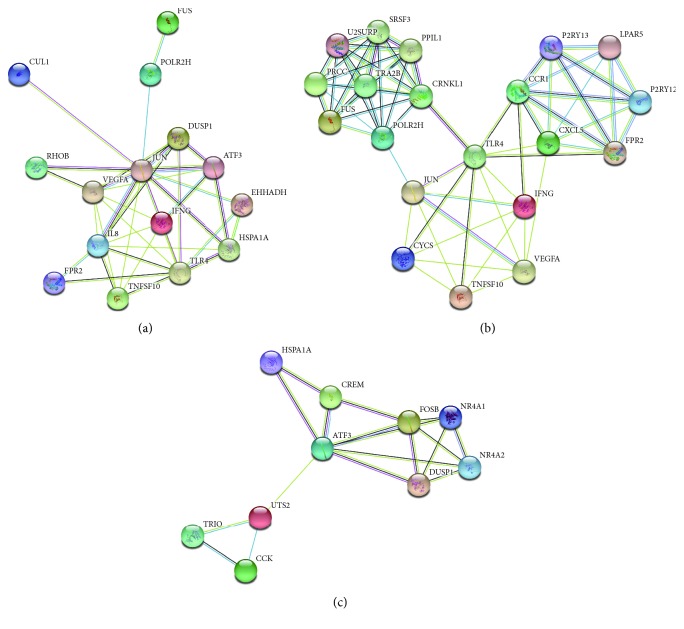
PPI network and module analysis of HCC. (a) PPI network of the top 15 hub genes via the information of the STRING protein query with maximum number of interactors ≤ 5 and confidence score ≥ 0.4. (b) PPI network of Module 1. (c) PPI network of Module 2.